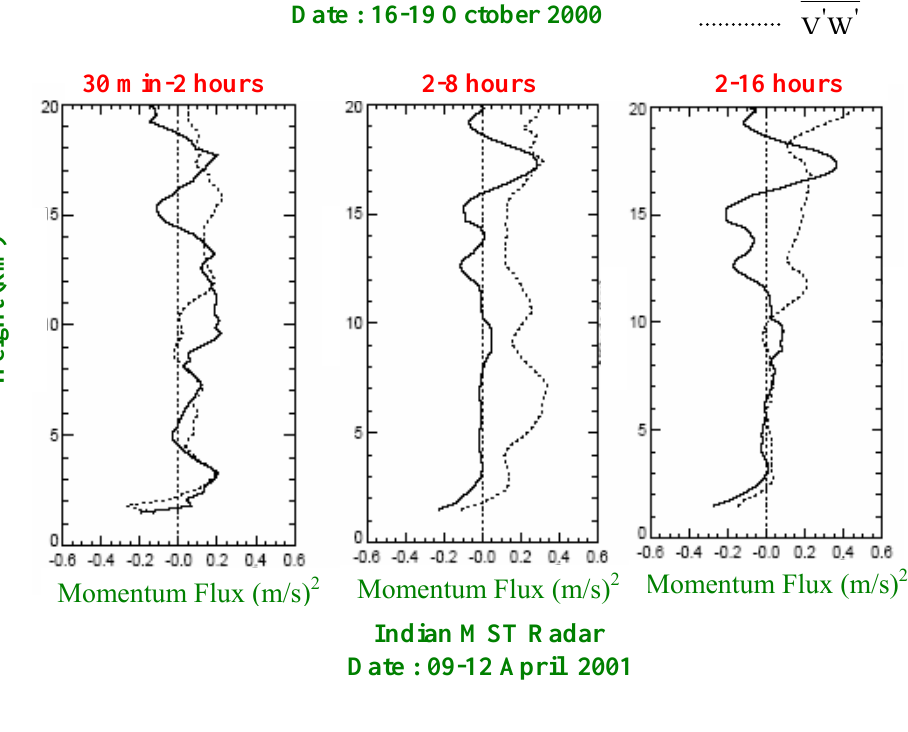
the meridional flux occur in the long periods (2–8, 2–16 h) towards northward. In particulary, in the height range of 13– 16.8 km, for both longer and shorter periods, the